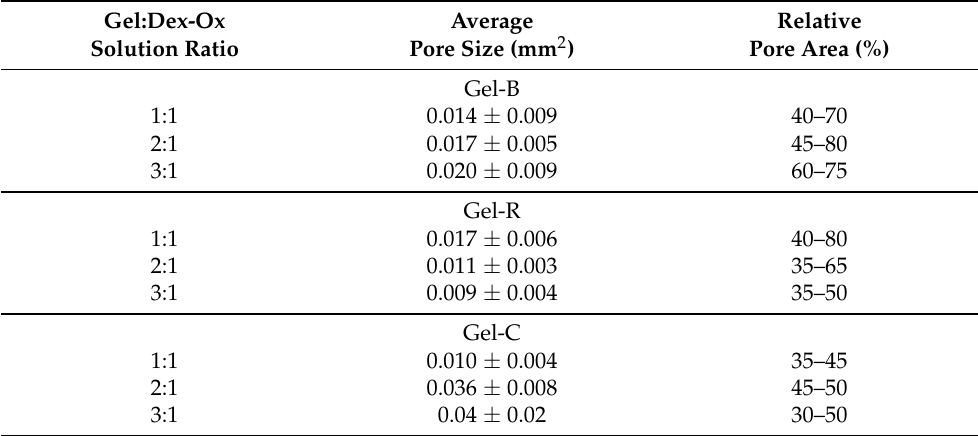
Table 3. Evaluation of pore size and porosity of hydrogels after shear strain and subsequent